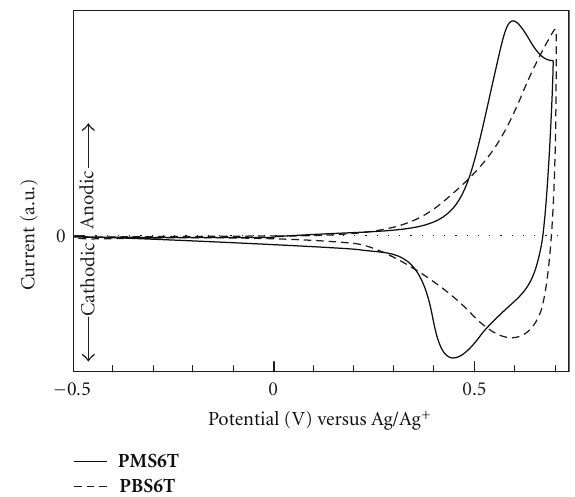
Figure 11: Cyclic voltammograms of PMS6T and PBS6T films in TEAP (0.1M)/acetonitrile at a scan rate of 50 mVs − 1 .